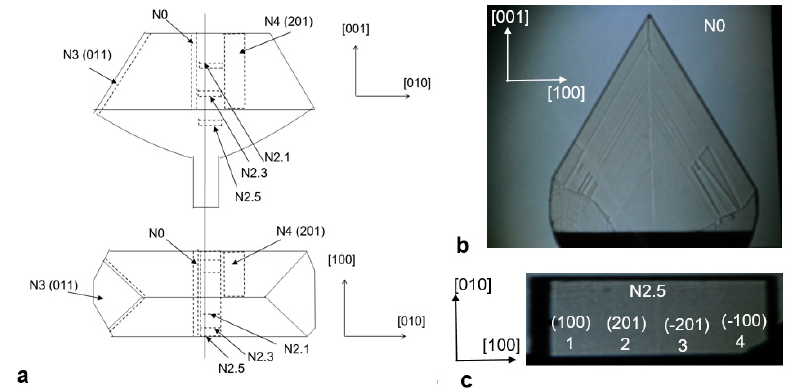
Figure 1. Scheme of the K 0.998 Rb 0.002 TiOPO 4 crystal ( a ) and di ff raction shadow images of samples N0 ( b ) and N2.5 ( c ) indicating growth sectors of di ff erent faces. Sample N0 was used for measurements of Rb distribution along the growth axis